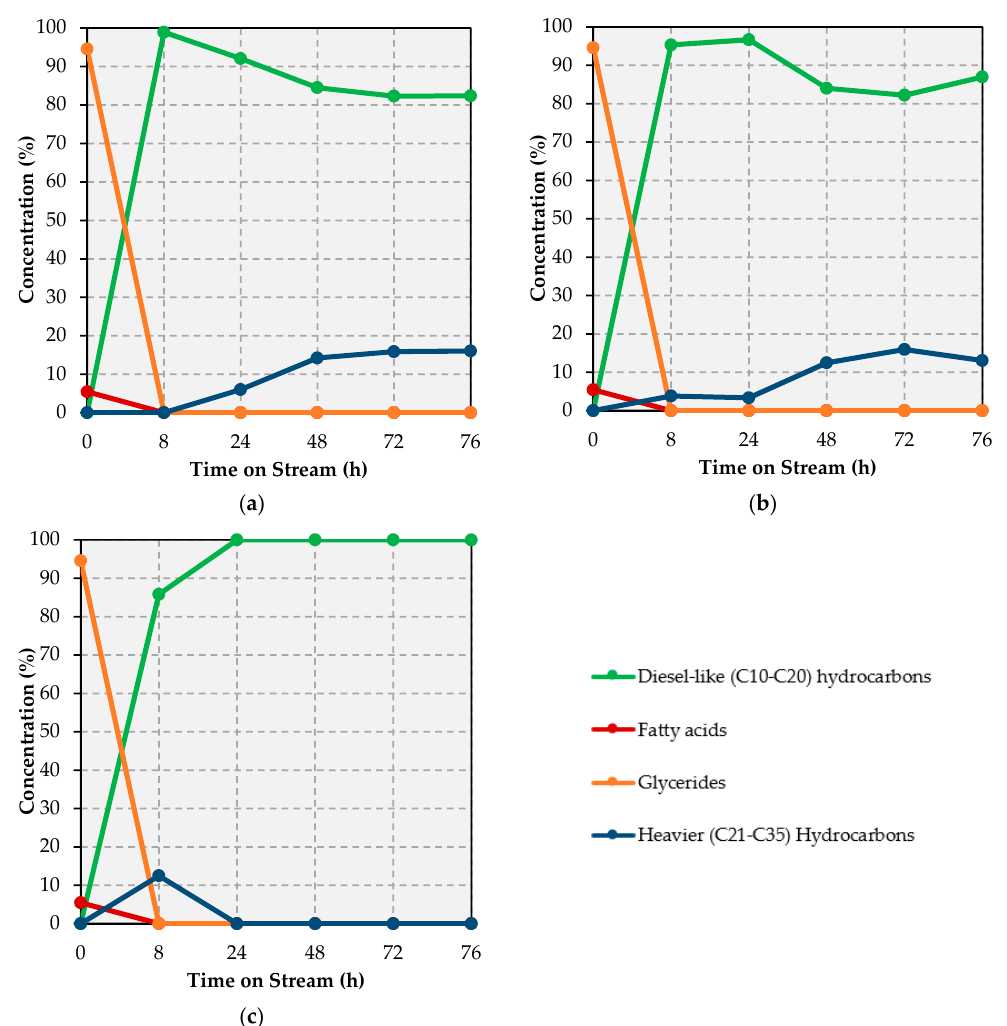
Figure 1. GC-MS analysis of the liquid products resulting from the deoxygenation of UCO over